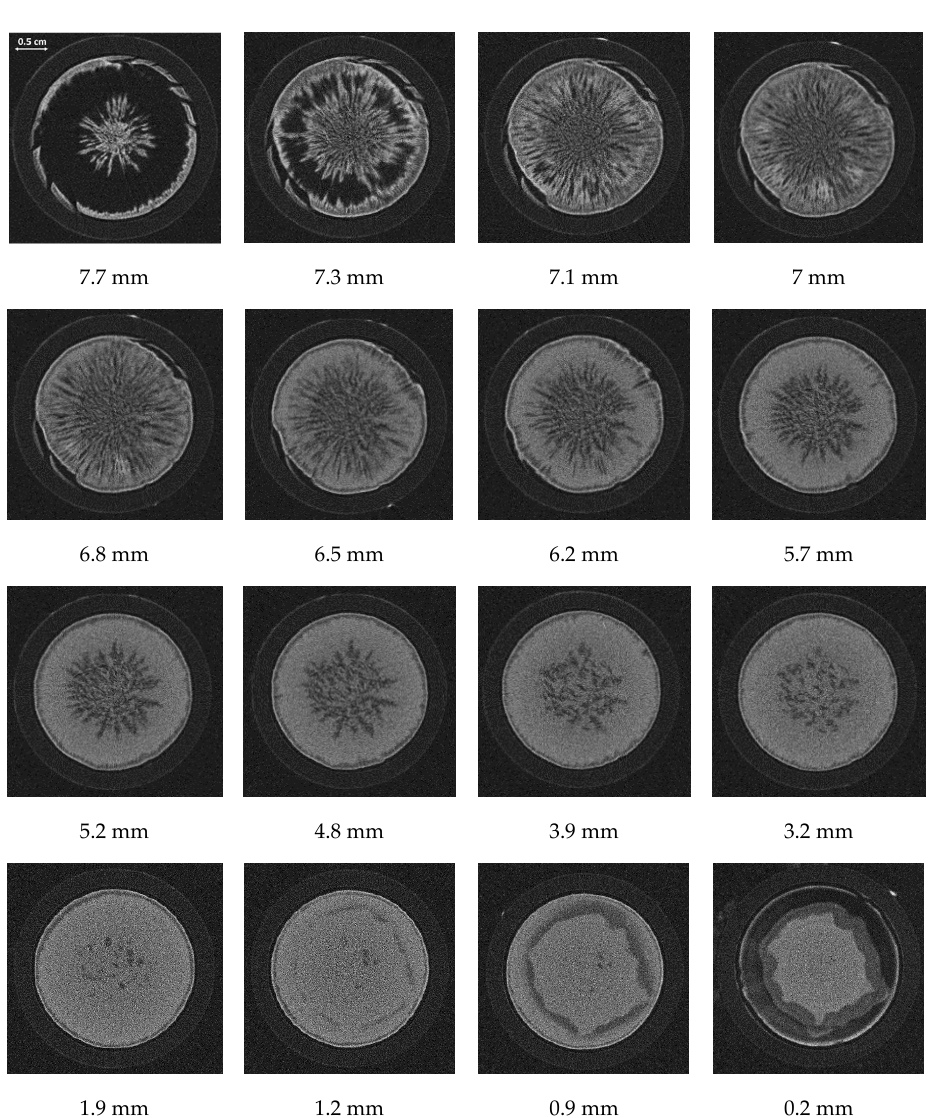
Figure 5. Series of horizontal cross-sectional slices of the tomographic volume reconstruction at different heights. The given positions are measured from the footprint of the sample.